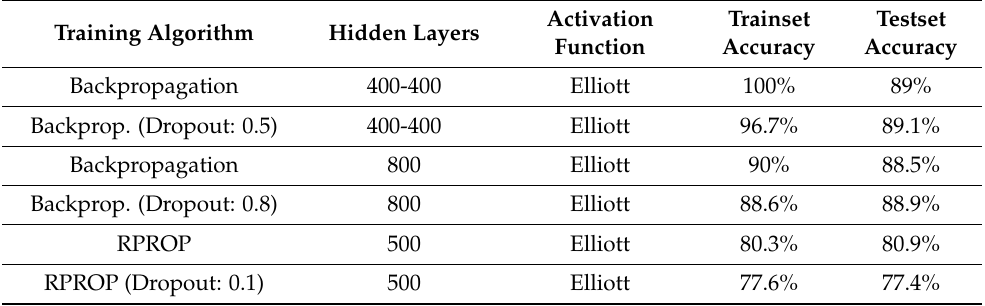
Table 3. Training with the Dropout technique.